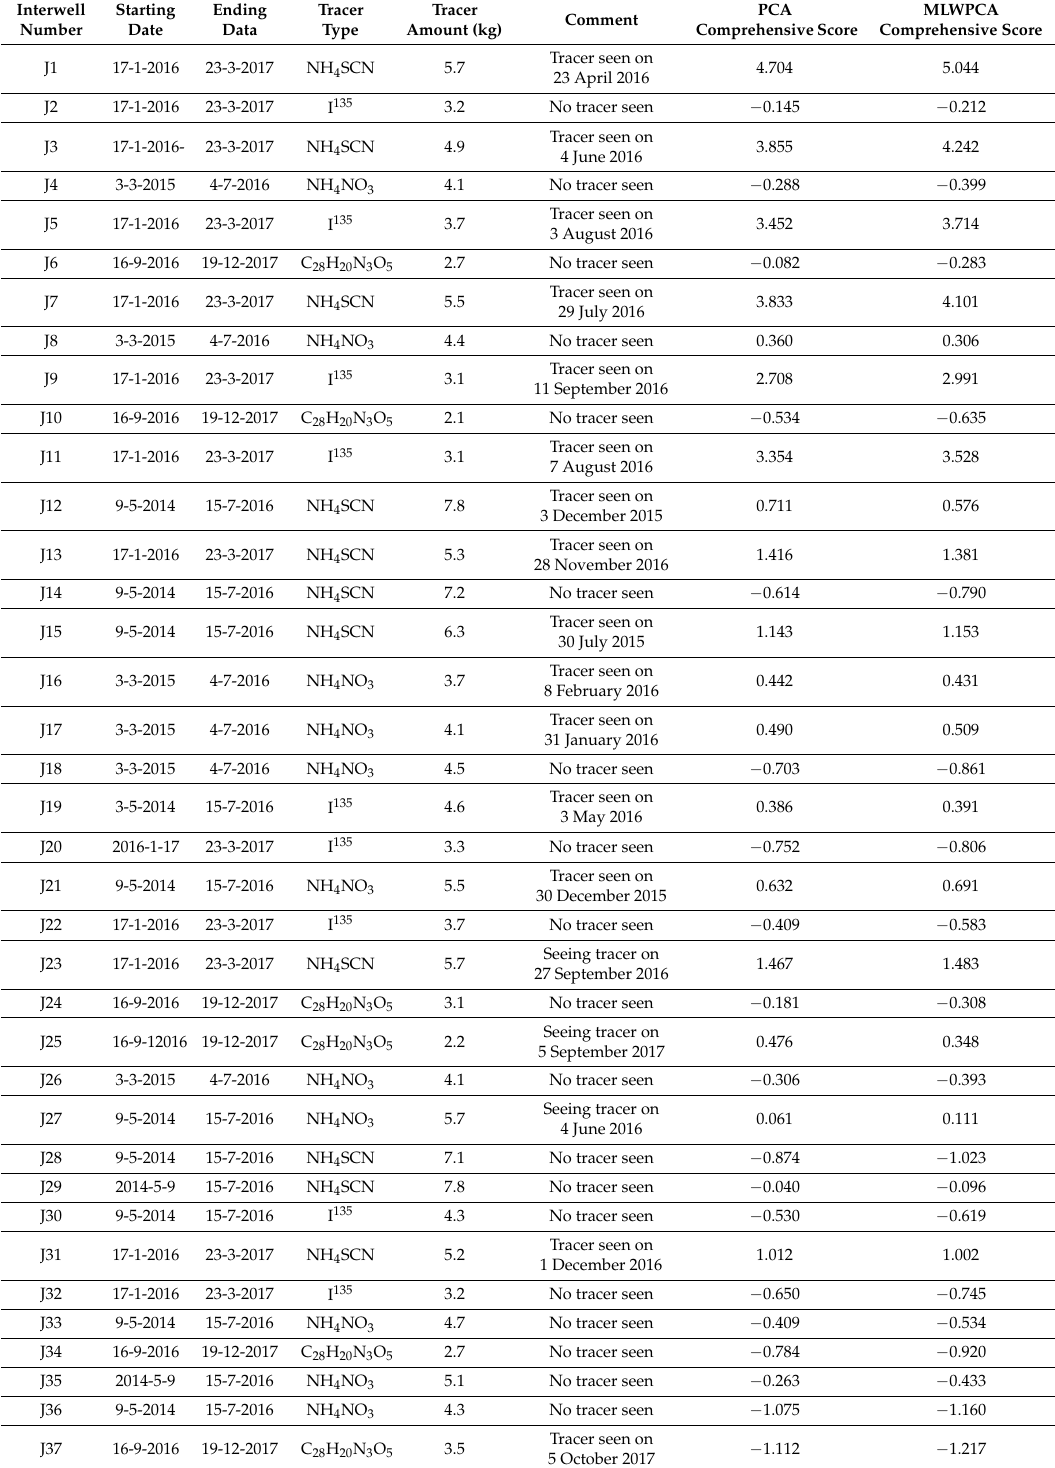
Table 6. Test results of the tracer